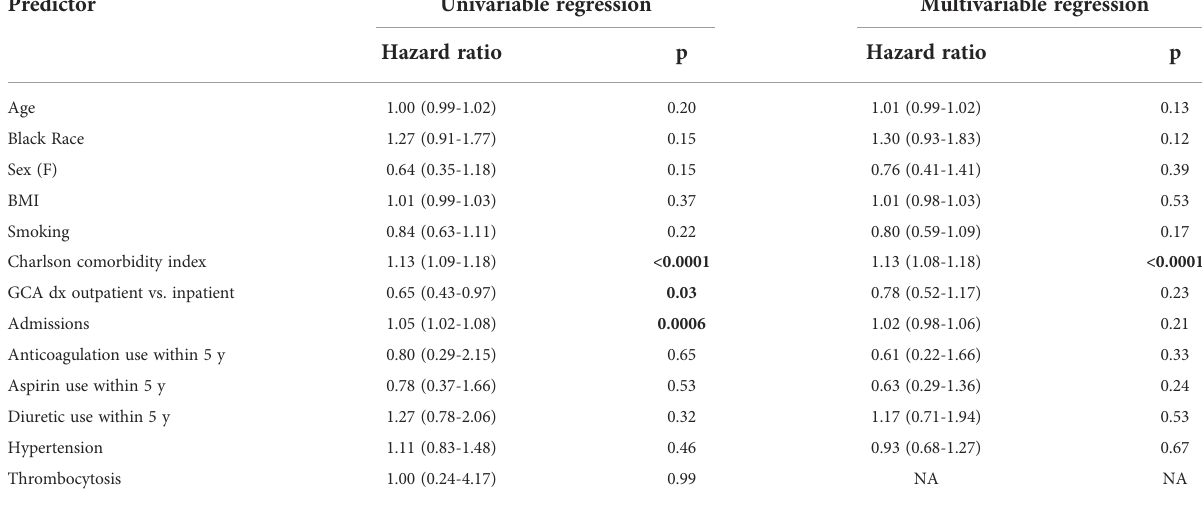
TABLE 2 Predictors for the incidence of PE after diagnosis of GCA.